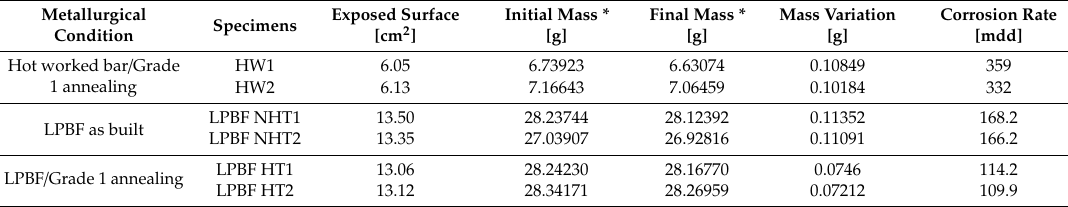
Table 1. Results of 120 h weight loss test in boiling ferric sulphate / sulfuric acid solution (ASTM G28).